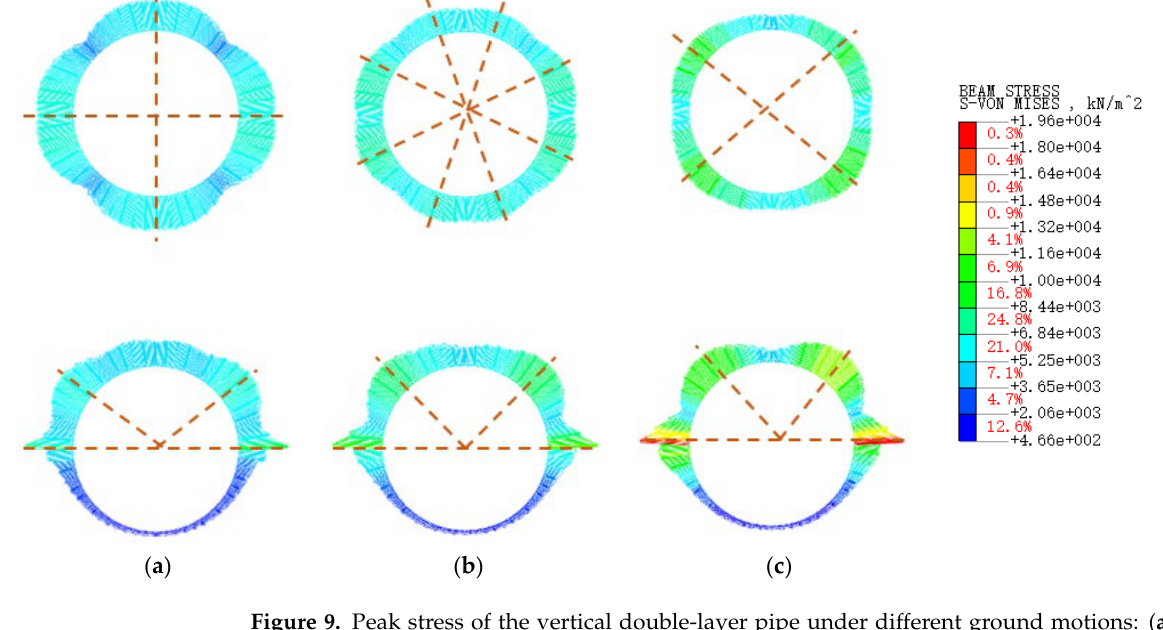
Figure 9. Peak stress of the vertical double- layer pipe under different ground motions: ( a ) 0.1 g; ( b ) 0.2 g; ( c ) 0.4 g.